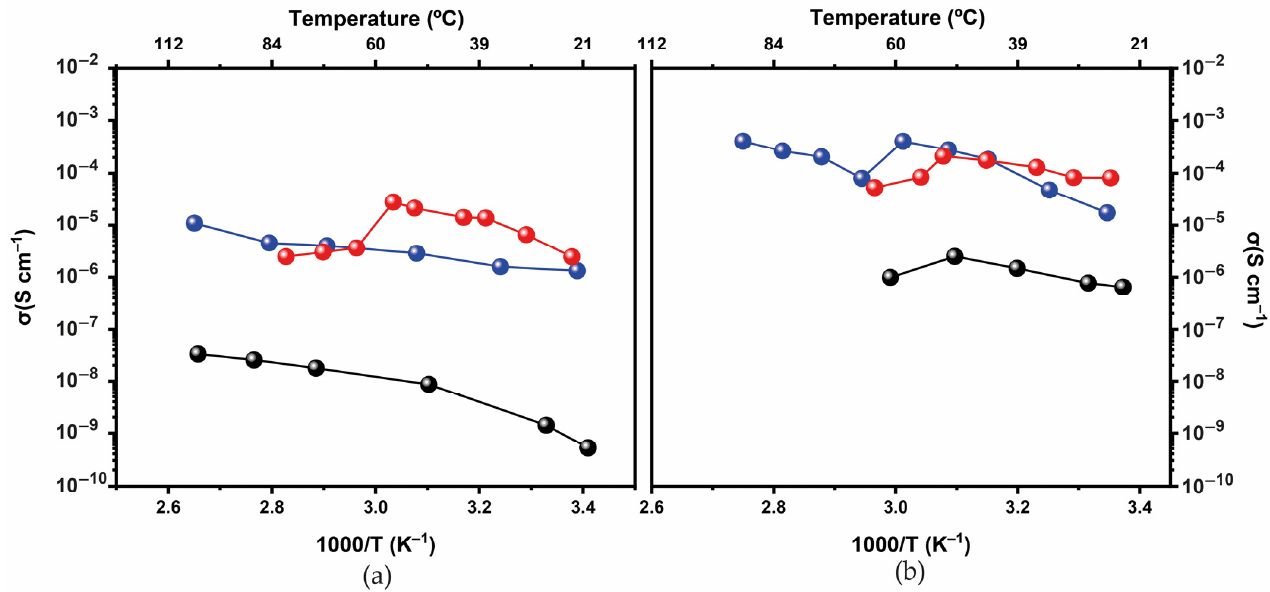
Figure 4. Ionic conductivity of d-U(600) ( a ) and d-(900)- ( b ) based di-ureasils. Non-doped materials (black symbols), materials doped with LiBF 4 and [Bmim]Cl (red symbols) and materials doped solely with [Bmim]Cl (blue symbols).